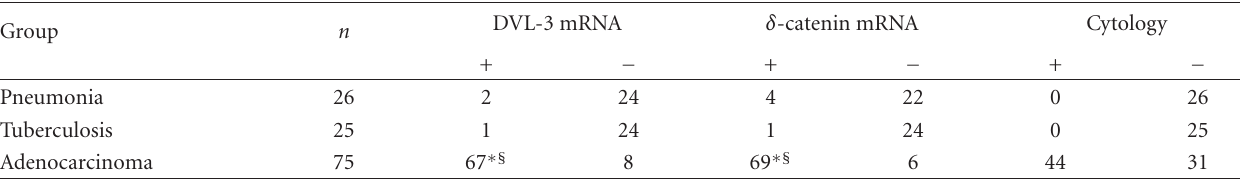
Table 2: Results for DVL-3 mRNA, δ -catenin mRNA expression by RT-PCR and for cytological assessment in pleural e ff usions of patients with benign or malignant lung